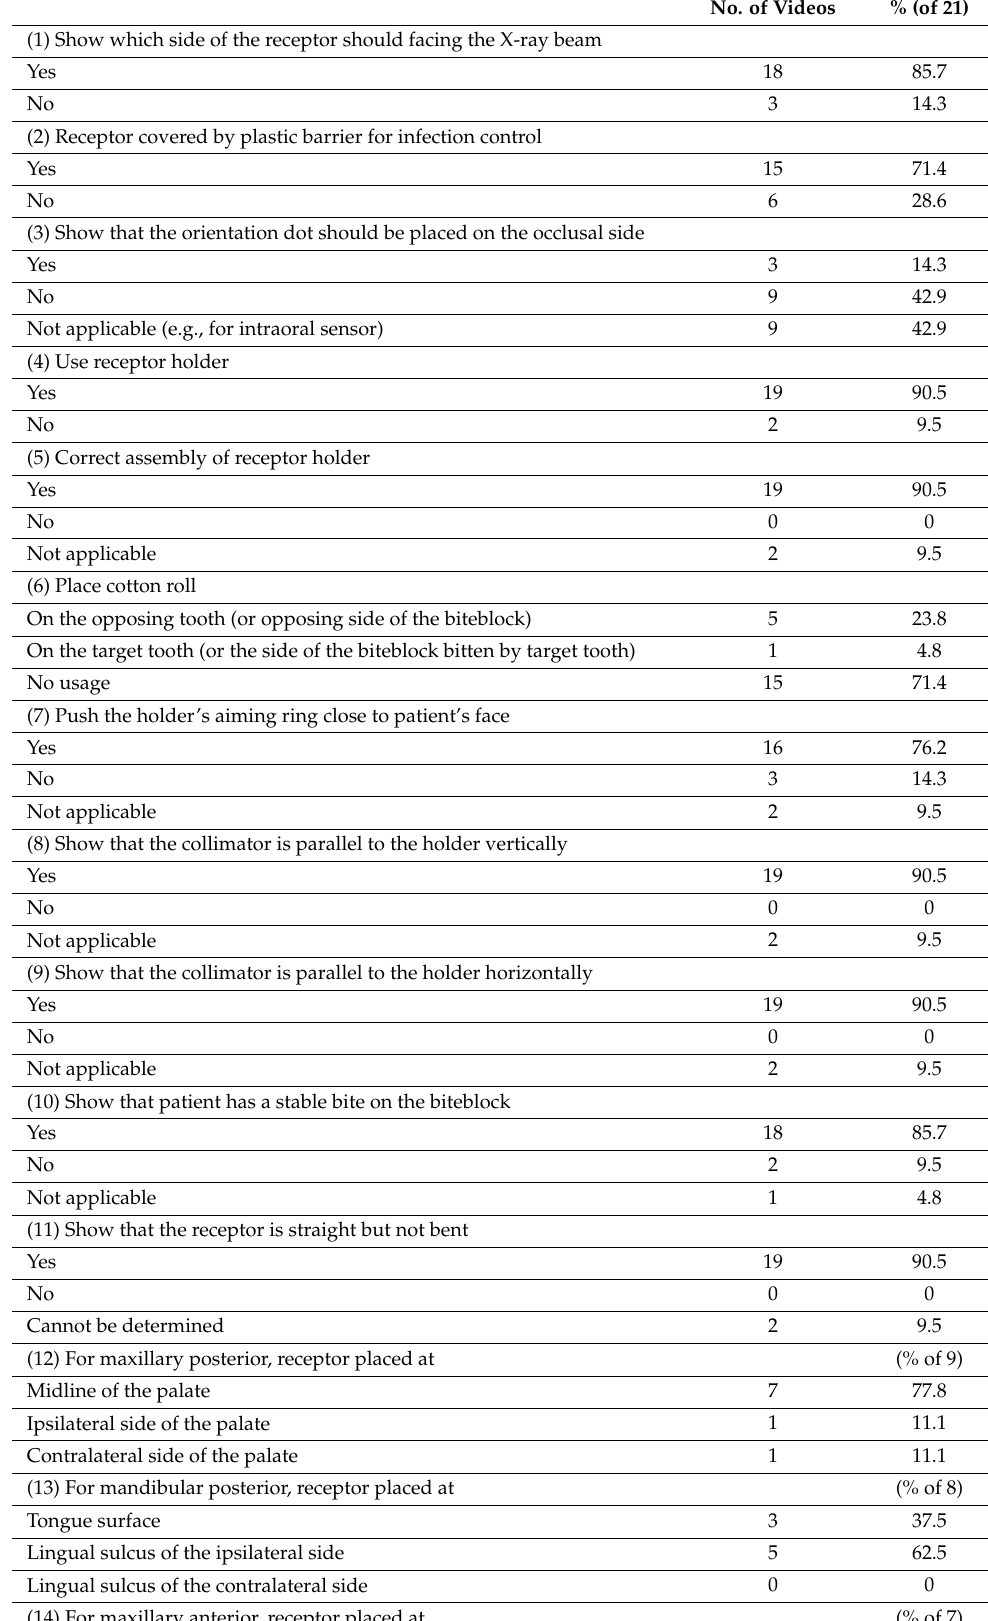
Table 2. The frequency counts of receptor placement